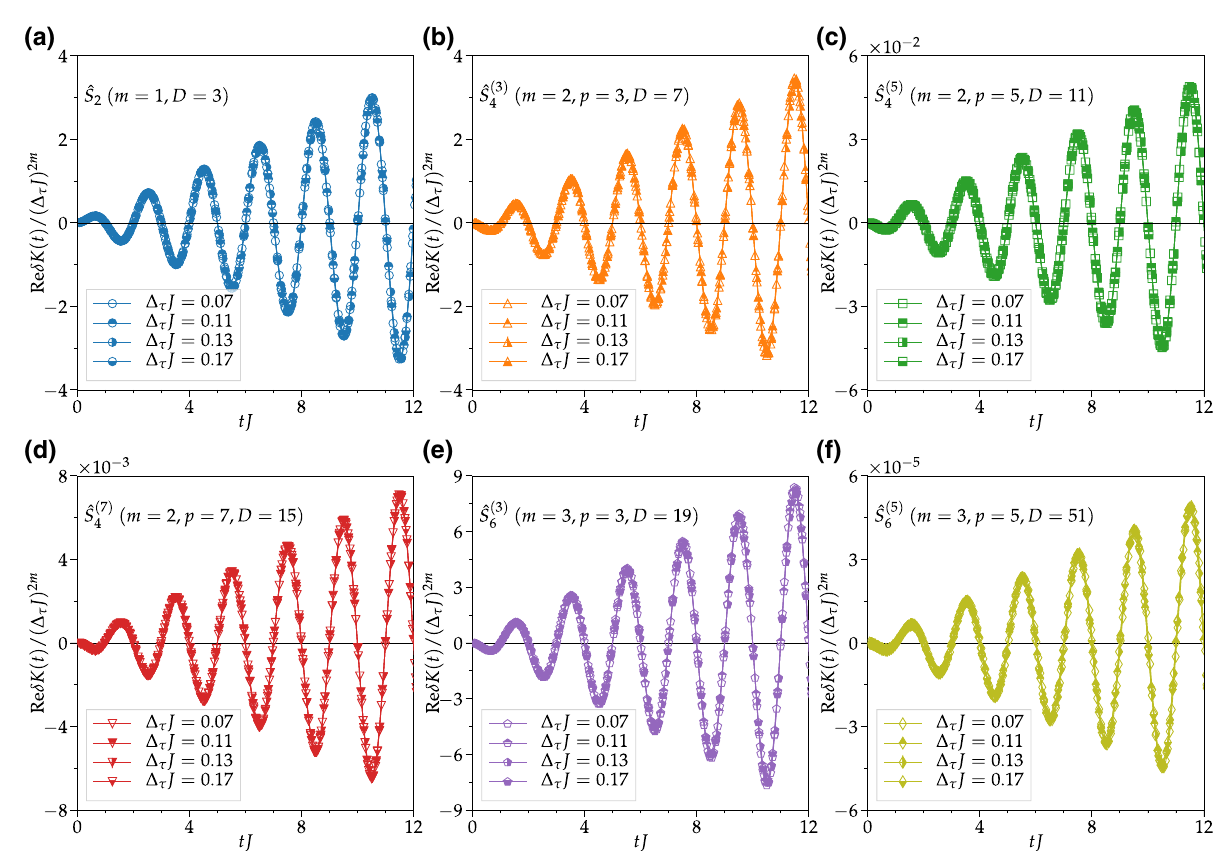
FIG. 17. Same as Fig. 16 but the deviation Re δ K ( t ) divided by ((cid:3) τ J ) 2 m for several values of (cid:3) τ as indicated in the figures.